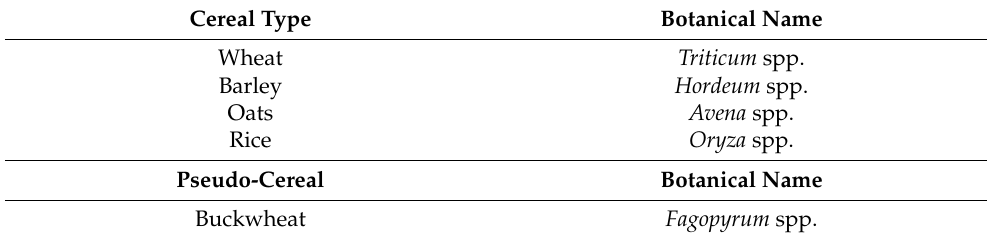
Table 4. Botanical names of whole grains used in the